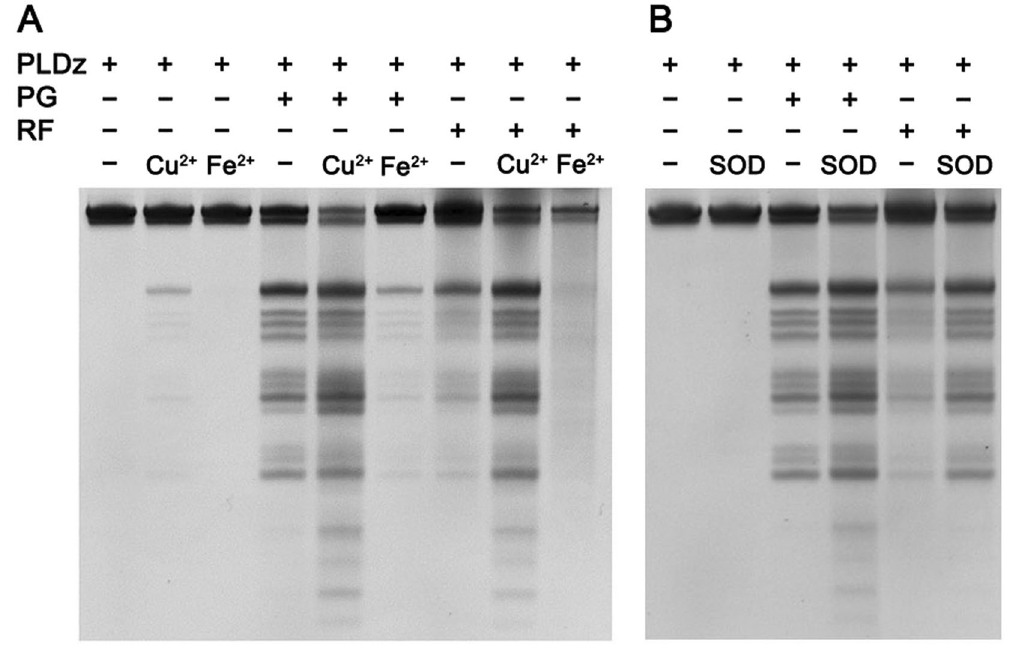
Figure 4. The function of pyrogallol (PG) and riboflavin (RF) on the catalytic activity of PLDz. ( A ) Effects of autoxidation of PG and photo-oxidation of RF on the cleavage reaction of PLDz. Reaction condition: 0.4 μ M PLDz, 100 μ M PG (RF), 100 μ M Cu 2 + (Fe 2 + ), 300 mM NaCl and 50 mM Tris-HCl (pH 7.0) at 23 °C for 2 hr. The reaction system containing RF need to performed under a sunlight lamp. ( B ) Effects of SOD on the cleavage reaction of PLDz in the presence of H 2 O 2 . Reaction condition: 0.4 μ M PLDz, 100 μ M PG (RF), 0.3 U/ μ l SOD, 300 mM NaCl and 50 mM Tris-HCl (pH 7.0) at 23 °C for 2 hr. Cropped gels are used in Fig. 4A,B, their full- length gels are presented in Supplementary Figure 9.